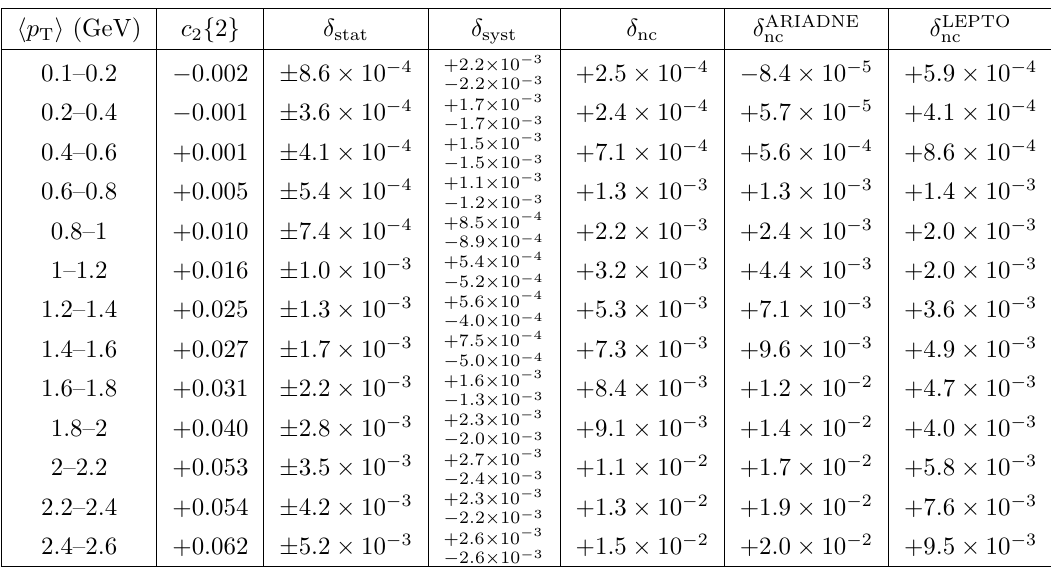
Table 23 . c 2 f 2 g versus h p T i from (cid:12)gure 9 (b), 15 (cid:20) N ch (cid:20) 30, p T > 0 : 1 GeV, j (cid:1) (cid:17) j > 2; (cid:14) stat , (cid:14)